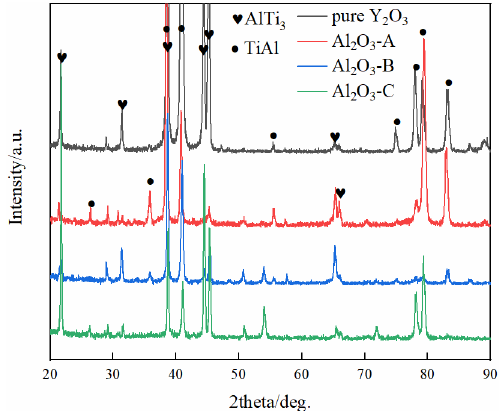
Figure 5. ( a – d ) are the internal microstructures of the metal particles obtained from the alloy melting experiments of pure Y 2 O 3 , Al 2 O 3 -A, Al 2 O 3 -B and Al 2 O 3 -C crucibles.